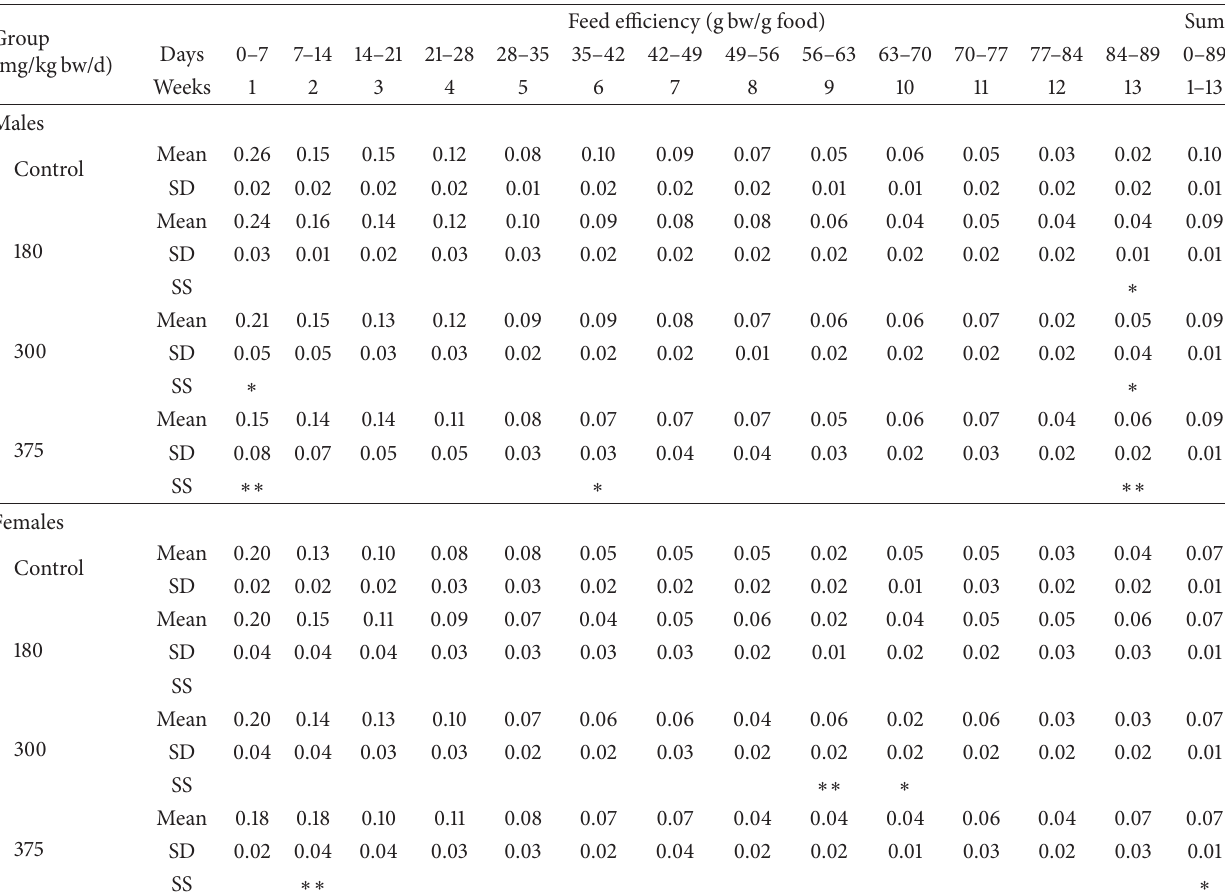
Table 6: Summary of feed